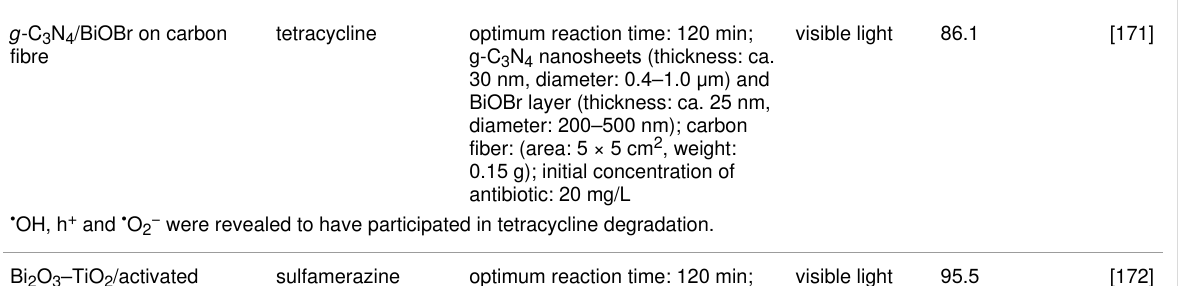
Table 8: Bi-based nanocomposite/heterojunction photocatalysts for antibiotic remediation. (continued) g -C 3 N 4 /BiOBr on carbon